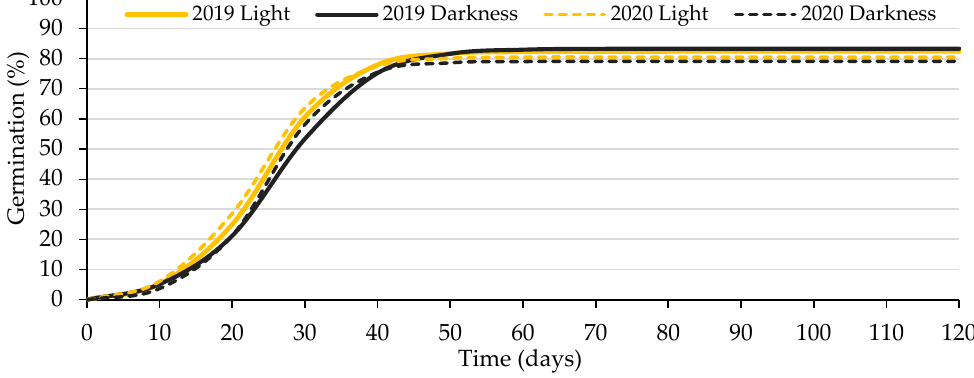
Figure 1. Logistic model adjusted to the curves of accumulated germination of caper seeds from Experiment 1. Average values of the combination of the seed lot (2019 and 2020) and the exposure to light-darkness of the seeds. A 500 mg L − 1 GA 3 solution was used to wet the